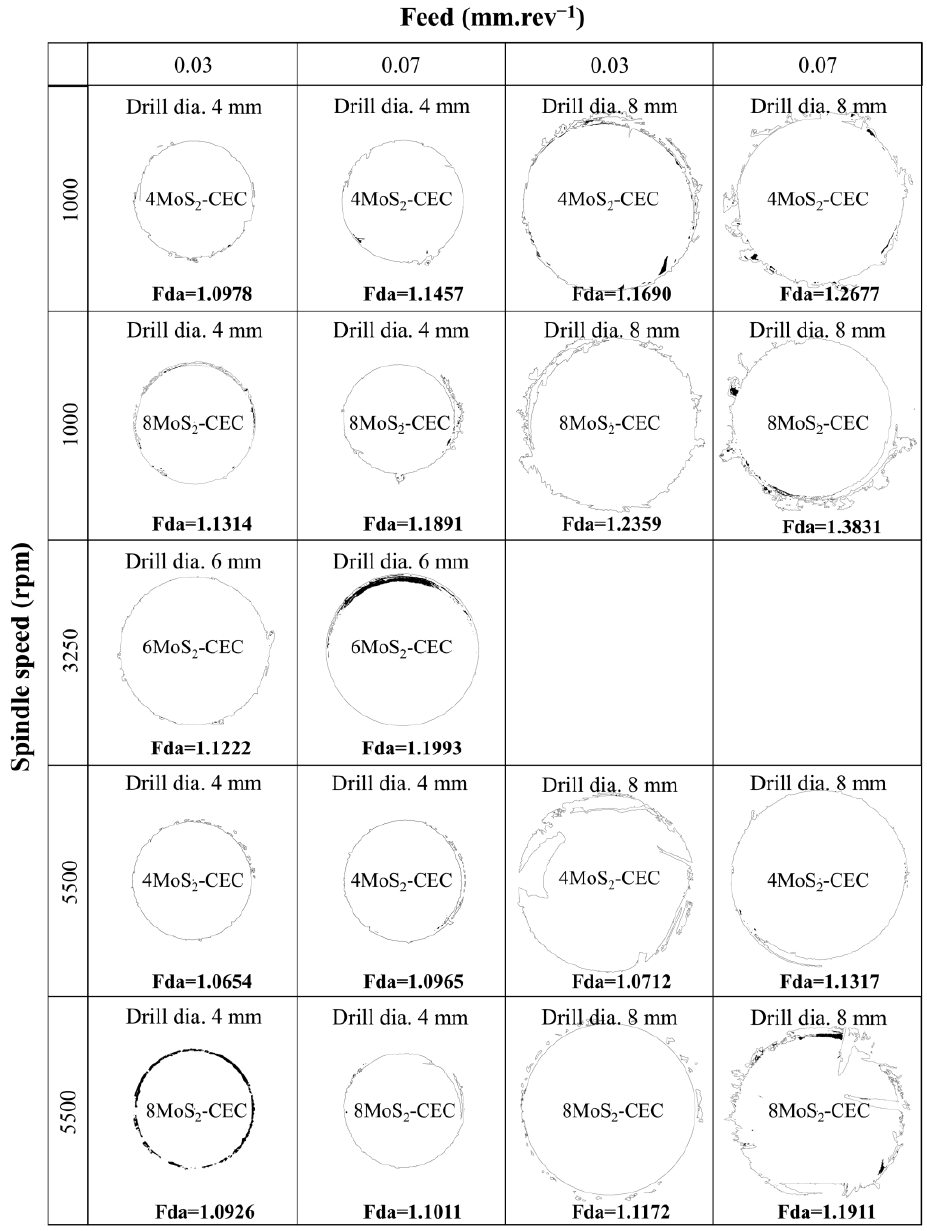
Figure 6. Delamination images of MoS 2 -loaded CEC under various drilling conditions. drilled with an 8 mm diameter drill at 1000 rpm spindle speed and 0.07 mm.rev − 1 feed.